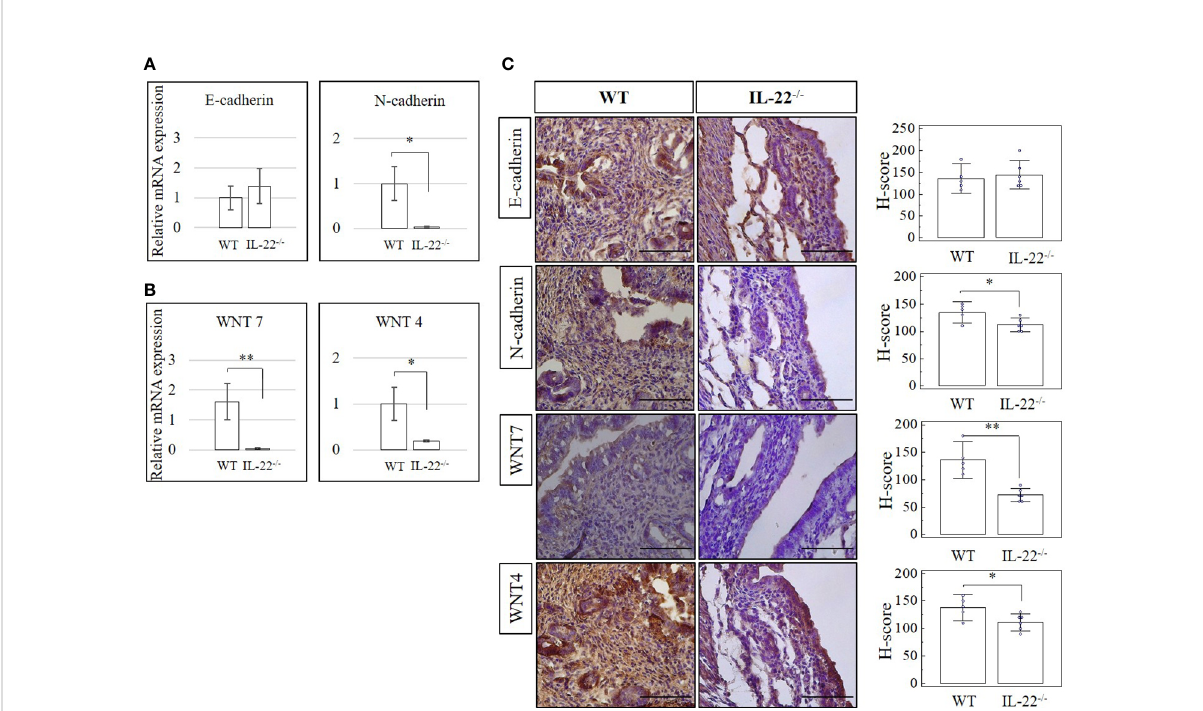
FIGURE 6 The expression of cadherin and WNT molecules in IL-22 − / − and WT mice. (A, B) IL-22 − / − , n = 6, and WT, n = 5, mouse uterine samples were harvested 48 h post intraperitoneal LPS injection. Total mRNA samples were extracted and processed by qRT-PCR to evaluate the expression of cadherin and WNT molecules, respectively. The Ct values were normalized against the Ct values for GAPDH from the same preparation. The data are provided as mean ± SEM from three independent experiments. (C) IL-22 − / − , n = 6, and WT, n = 5, mouse uterine samples were harvested 48 h post intraperitoneal LPS injection, frozen fi xed, and processed for IHC analysis. H-score of cadherin and WNT molecules was calculated to measure whether the difference in the staining between the groups is statistically signi fi cant. The data from t-test are provided as mean ± SEM. WT, wild type; IL-22 − / − , IL-22 knockout; H-score, histological score; WNT, wingless-related integration site; LPS, lipopolysaccharide; IHC, immunohistochemistry. Original magni fi cation, ×40; scale bar, 100 µm. * p <